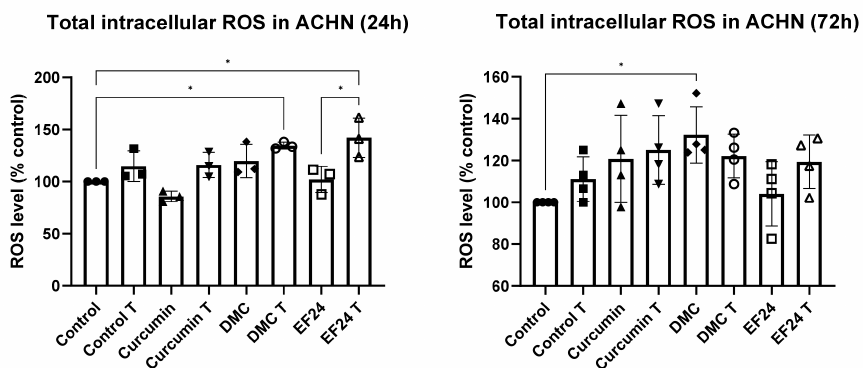
Figure 1. Total ROS production measured using a fluorogenic substrate, in ACHN kidney cancer cells after a 24 h or 72 h treatment with curcumin, DMC and EF24 individually and in combination with TRAIL. At 24 h, there was a significant increase in ROS production compared to the vehicle control in cells treated with DMC + T (134.44%) and cells treated with EF24 + T (142.05%). After 72 h, the increase in ROS was only significant following DMC treatment (132.22%). 24 h n = 3; 72 h n = 4. * p < 0.05.